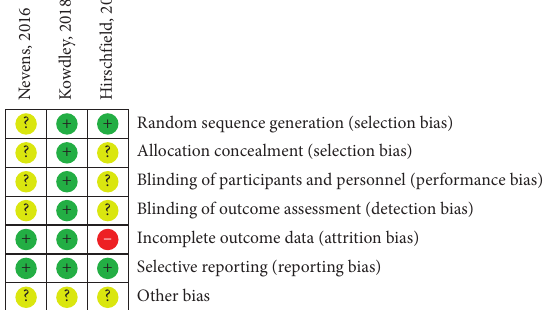
Figure 2: Risk of bias of the included studies evaluated according to each quality item. +, low risk; − , high risk; ?, unclear